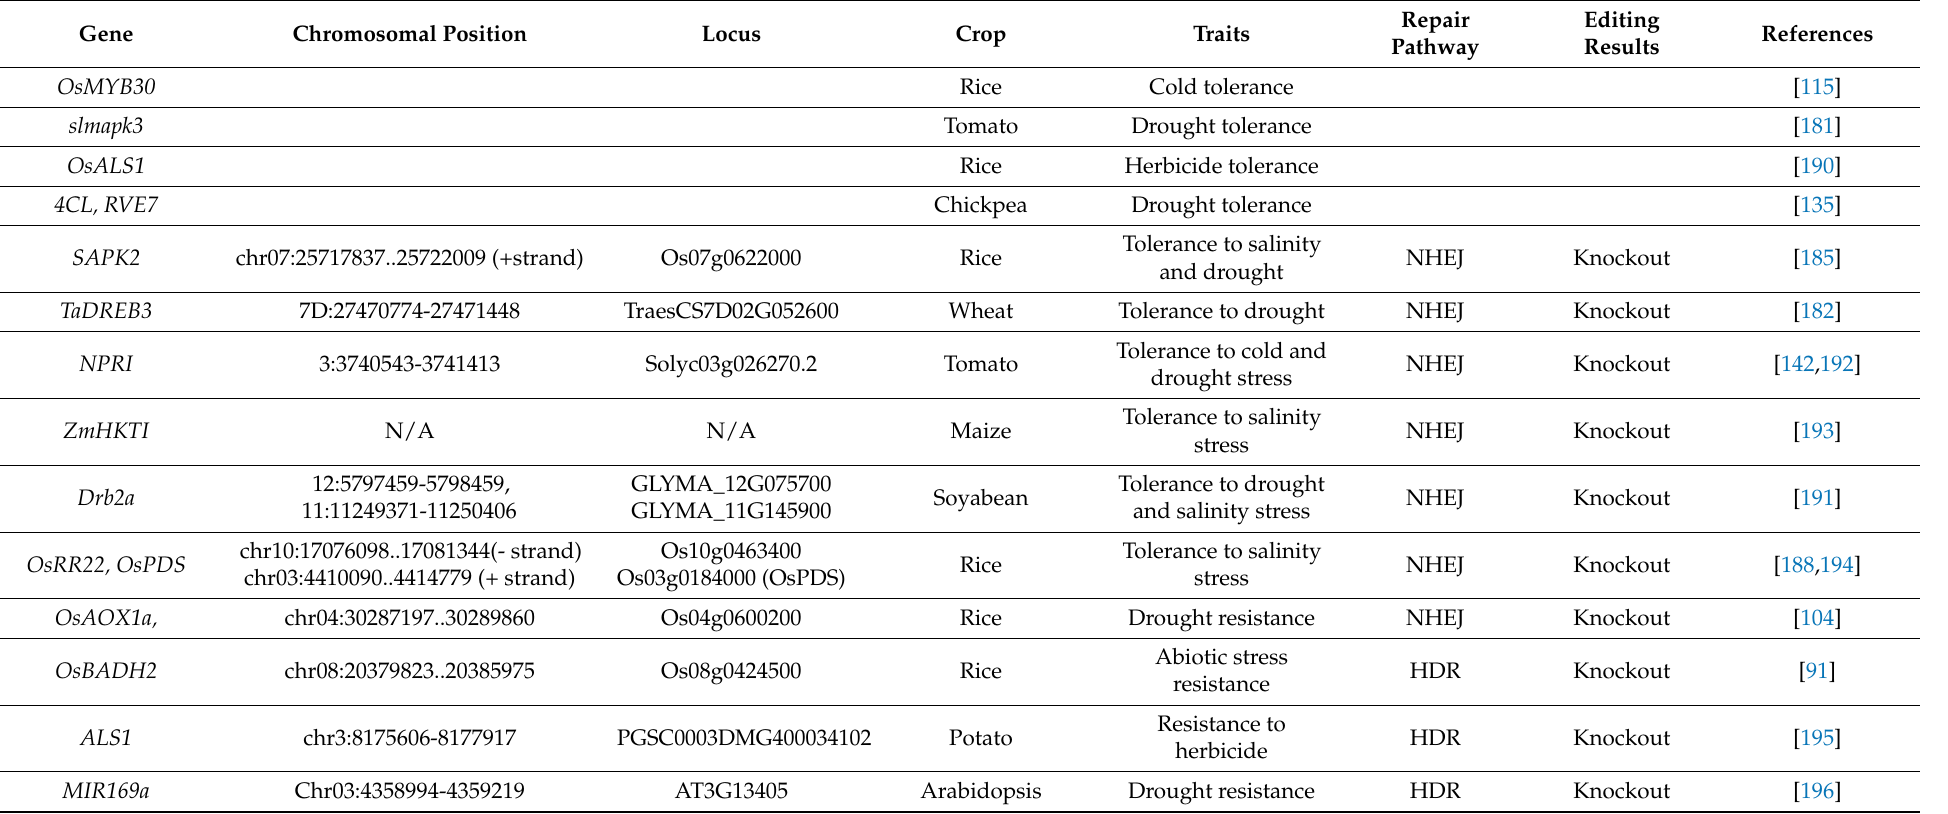
Table 6. Development of climate smart crops using